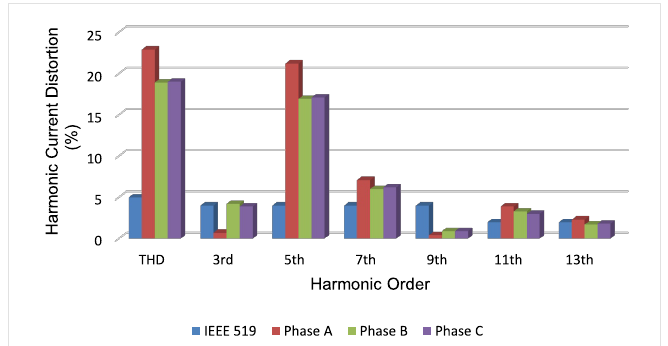
Figure 11. Three-phase grid current harmonic profile with the DHPF-NSI disabled.